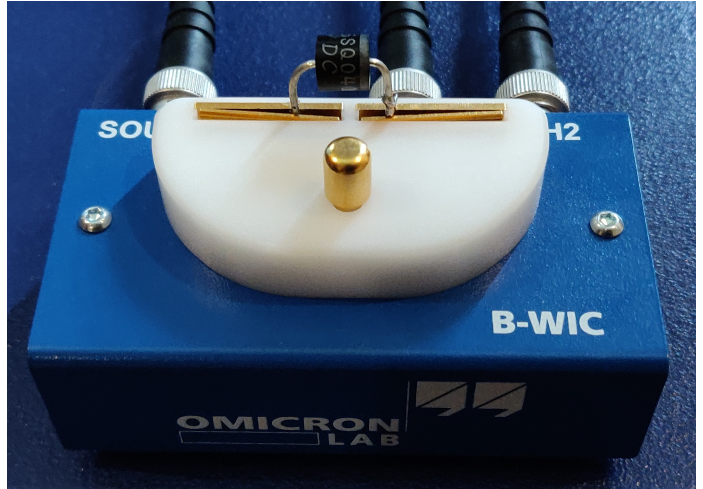
Figure 16. The OMICRON Lab B-WIC impedance adapter for THT